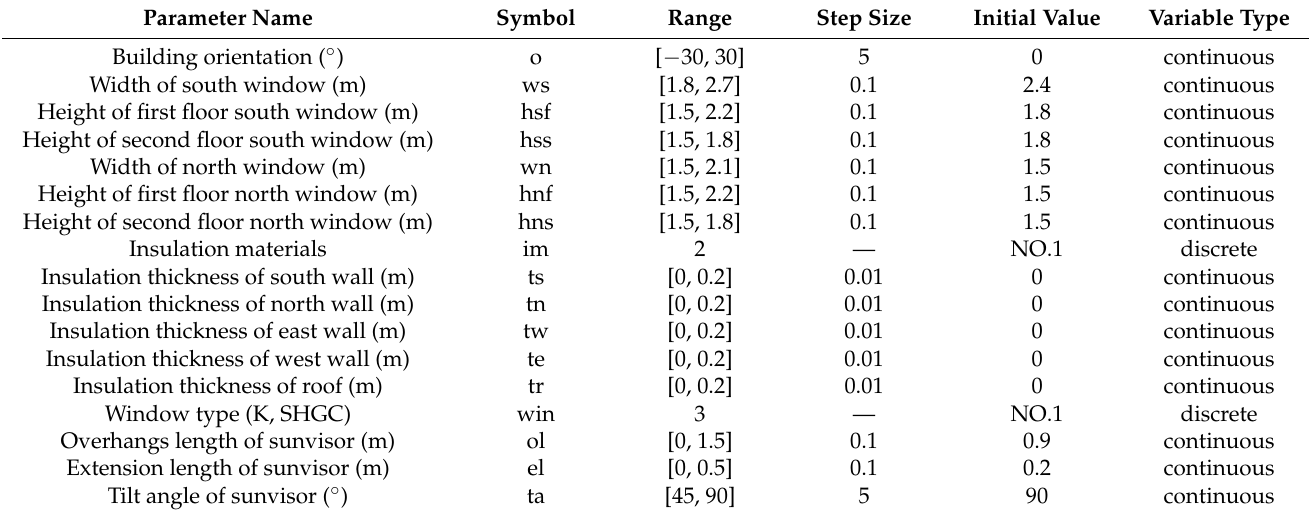
Table 10. Parameter settings for the design variables.